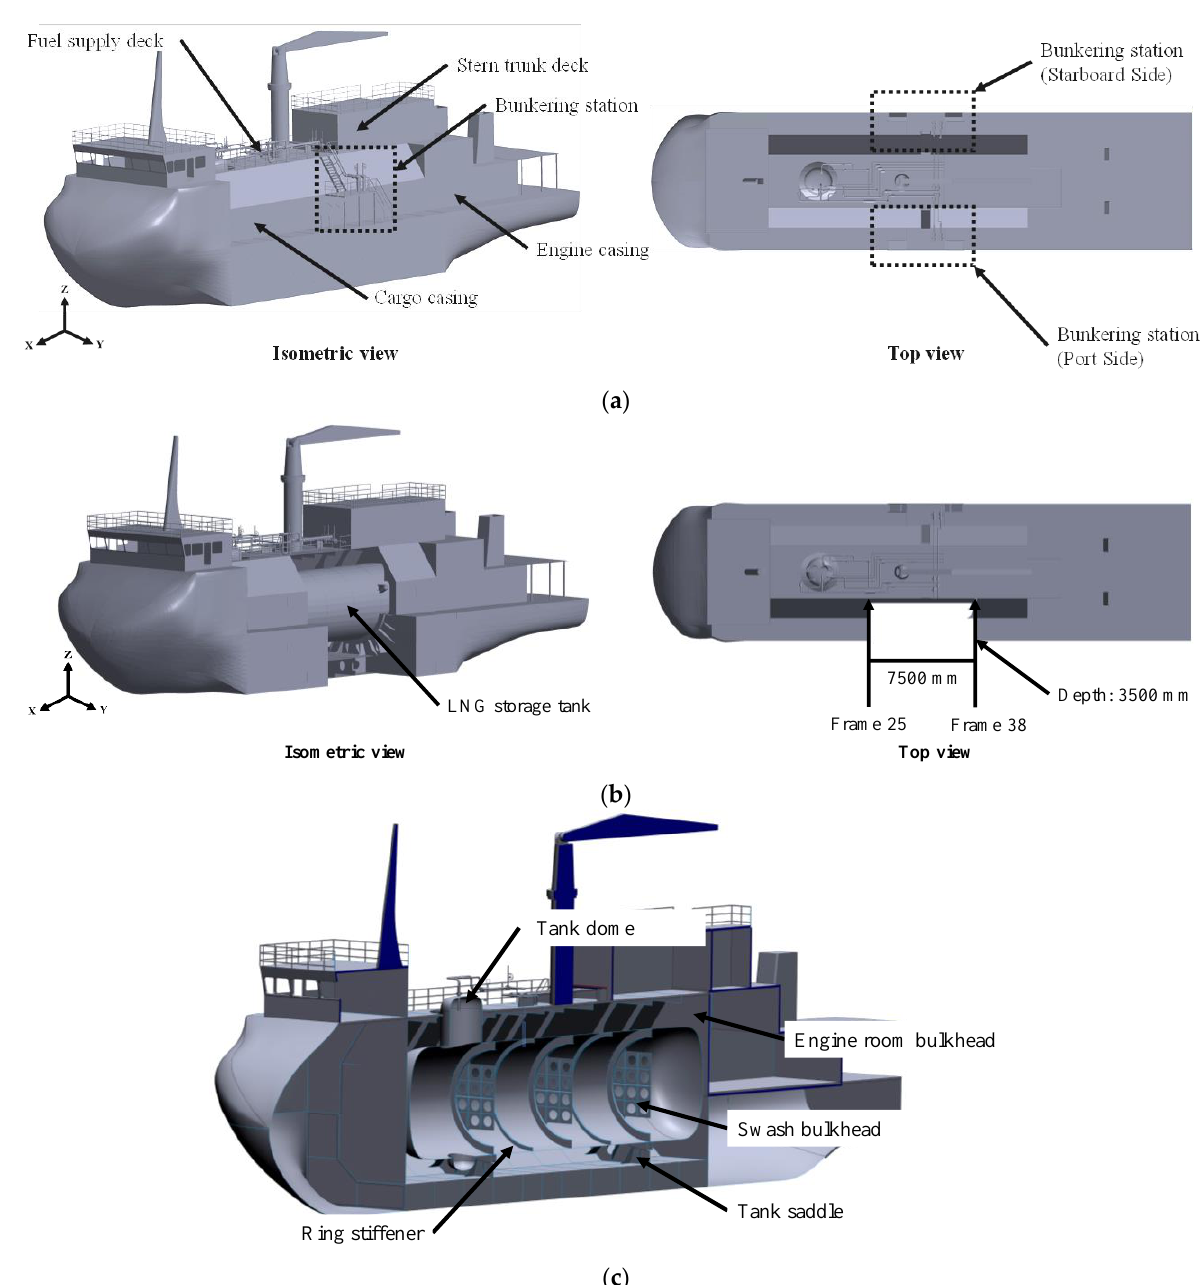
Figure 3. Initial ( a ), damaged geometries ( b ) and cut view ( c ) of the LNG bunkering ship model.